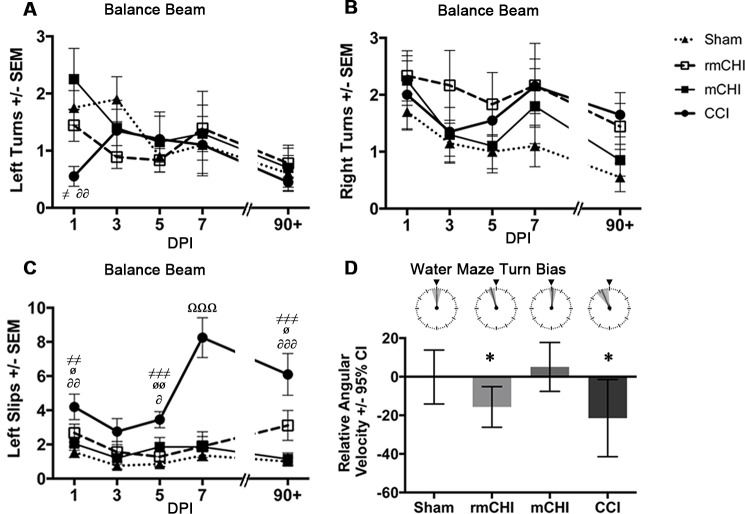
Turn bias was most evident in the mice with CCI.(A) At 1 dpi, CCI mice made significantly fewer left turns (contralateral to the injury) on the balance beam than sham (≠p<0.05) and mCHI (∂∂p < .01) mice. (B) Both rmCHI and CCI mice exhibited more turns to the right throughout balance beam testing than shams, though these results did not reach statistical significance. (C) CCI mice made more left-sided slips on the balance beam than other animals. These deficits were most prominent at 7 dpi compared to shams and other injury groups (aaap<0.001) and persisted up to 90+ dpi (≠≠p<0.01 vs. sham, ≠≠≠p<0.001 vs. sham, øp<0.05 vs. rmCHI, øøp<0.01 vs. rmCHI, ∂p<0.05 vs. mCHI, ∂∂p<0.01 vs. mCHI, ∂∂∂p<0.001 vs. mCHI). (D) In the water maze, rmCHI and CCI mice tended to swim to the left (contralateral to the injury) compared to sham and mCHI animals (*p<0.05, **p<0.01; mean +/- 95% CI). 95% confidence intervals show that the left turn biases in rmCHI and CCI mice are statistically significant (p<0.05), whereas no significant turn bias is observed in the sham and mCHI mice. (The clock graphic above shows variance markings of the relative angular velocity of each injury group with each mark on the clock representing a separation of 6° in relation to 12 o’clock. Flag symbol marks zero degrees).